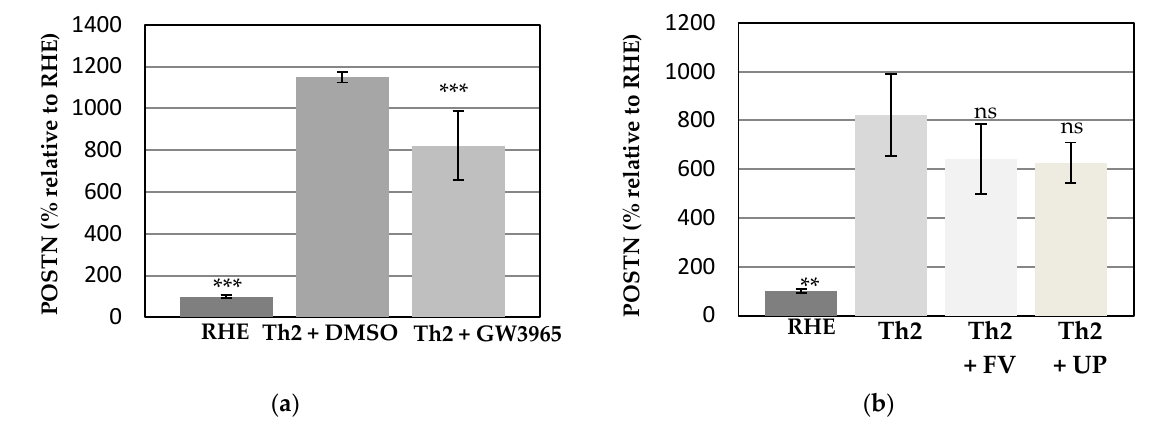
Figure 3. Changes in the periostin (POSTN) abundance in ( a ) Th2-induced RHE in 0.05% DMSO and in the presence of GW3965 and ( b ) in the presence of FV and UP. Data are given in percentage relative to the untreated condition. (*** p < 0.001 and ** 0.001 < p < 0.01).